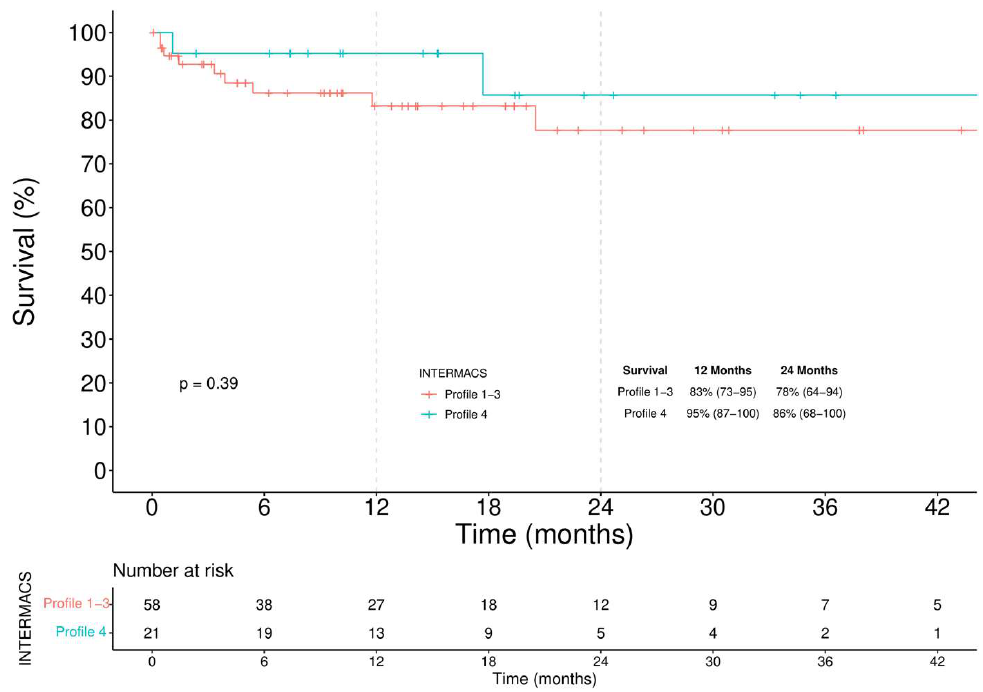
Figure 3. Kaplan-Meier analysis of survival stratified by different implantation strategies.